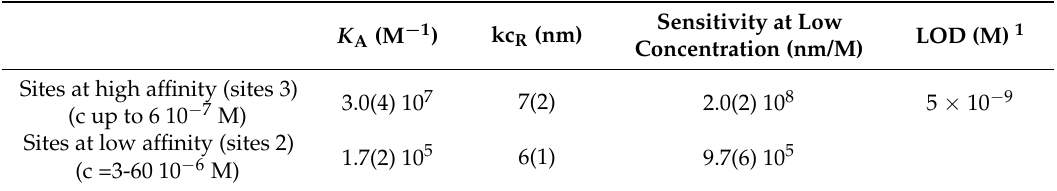
Figure 9. Scatchard plot (Equation (7)) for the data from the spectrum in Figure 7. Adsorption of 2-FAL on MIP-DVB from water, monitored by the D-shaped POF-MIP-SPR sensor. Table 2. Binding parameters of 2-FAL on MIP determined by the D-shaped POF-MIP-SPR sensor SPR-MIP by Scatchard plot, and sensing parameters.